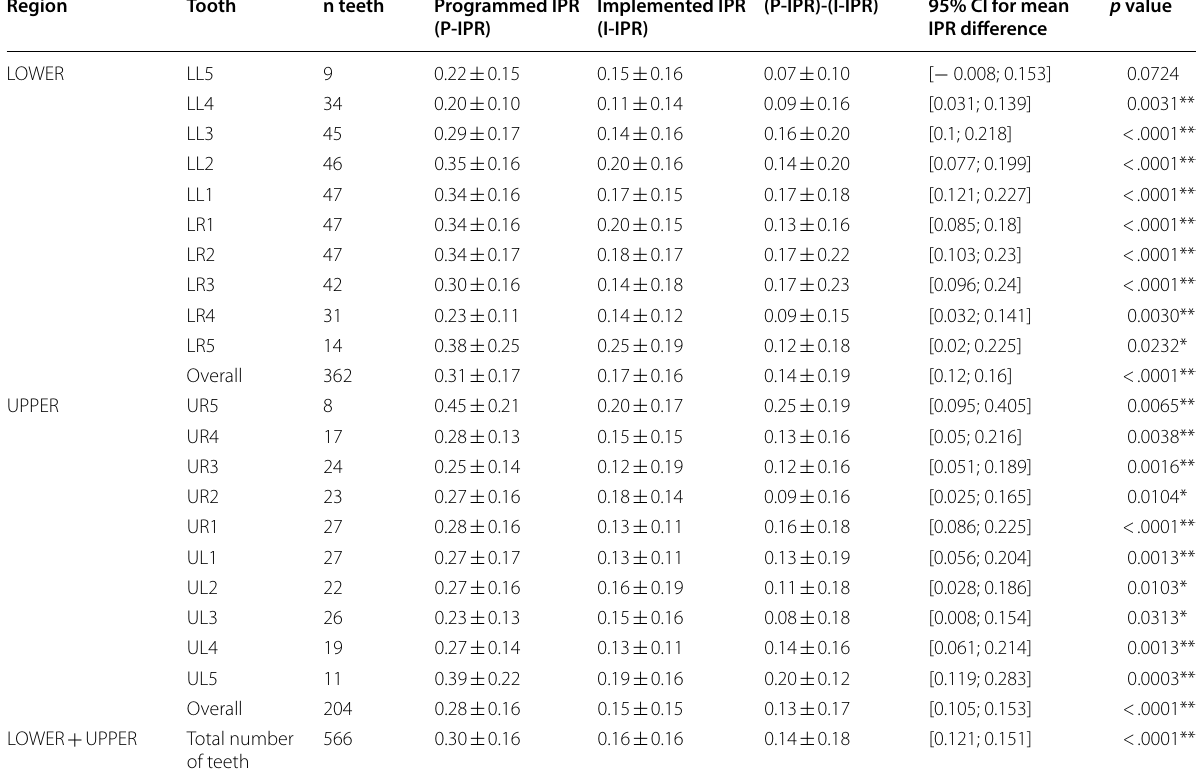
LL5 lower left second premolar, LL4 Lower left first premolar, LL3 lower left canine, LL2 lower left lateral incisor, LL1 lower left central incisor, LR1 lower right central incisor, LR2 lower right lateral incisor, LR3 lower right canine, LR4 lower right first premolar, LR5 lower right second premolar, UR5 upper right second premolar, UR4 Upper right first premolar, UR3 Upper right canine, UR2 Upper right lateral incisor, UR1 Upper right central incisor, UL1 Upper left central incisor, UL2 Upper left lateral incisor, UL3 Upper left canine, UL4 Upper left first premolar, UL5 Upper left second premolar, IPR Interproximal reduction, P-IPR Programmed IPR, I-IPR Implemented IPR, CI Confidence